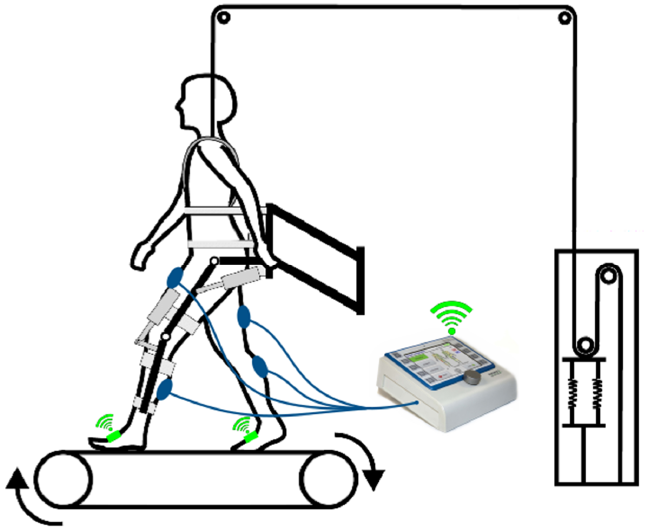
Figure 1. Concept: Lokomat with inertial measurement units (IMUs) and functional electrical stimulation (FES), adapted from [19].